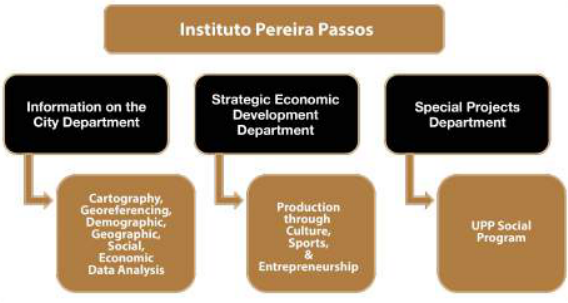
Figure 2. Functions of the Instituto Pereira Passos [77].